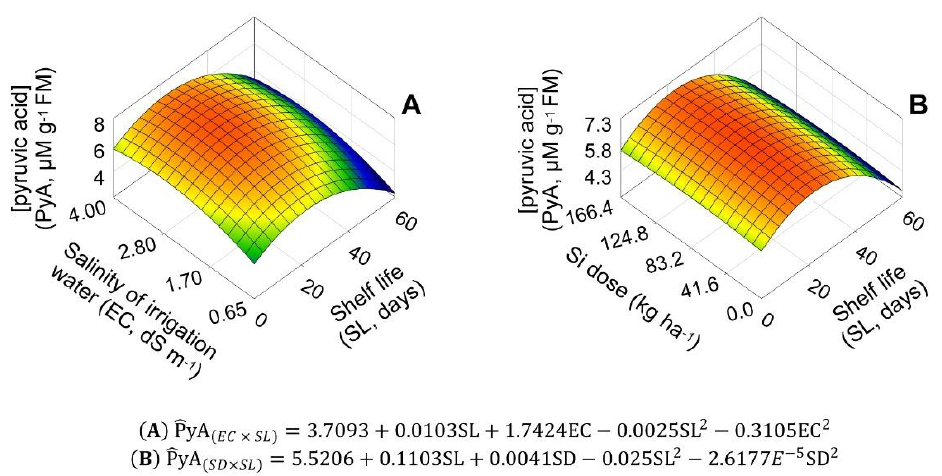
Figure 9. Unfolding of the treatment factors of salinity of irrigation water (EC) ( A ) and silicon dose (SD) ( B ), with shelf life (SL), for the variable pyruvic acid concentration (PyA, µ M g − 1 FM) in ‘Rio da Antas’ onion bulbs.